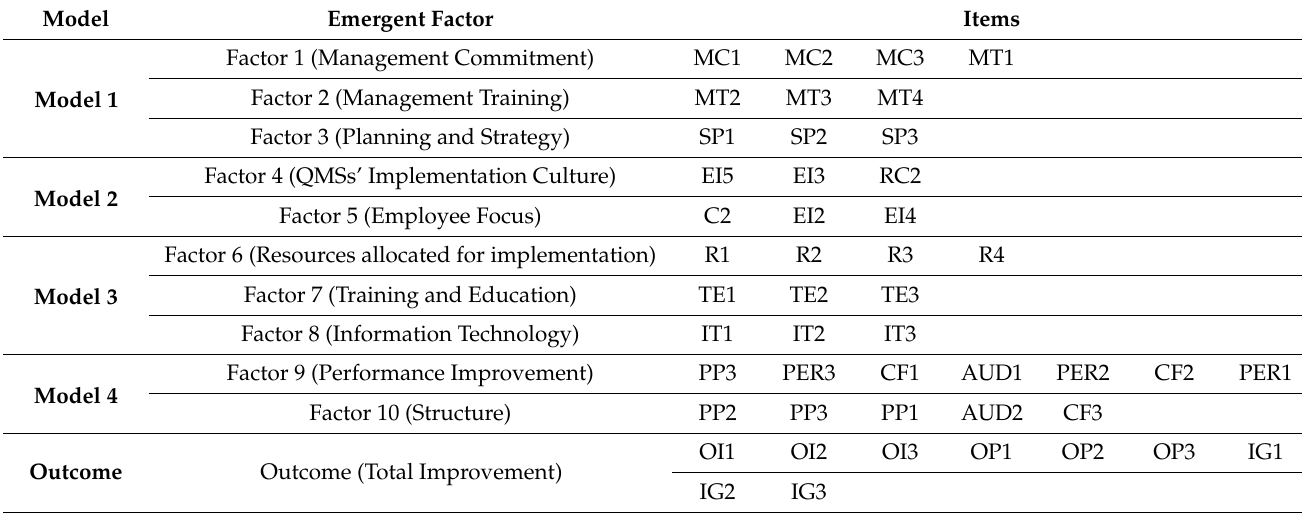
Table 3. Emergent factors and their items.